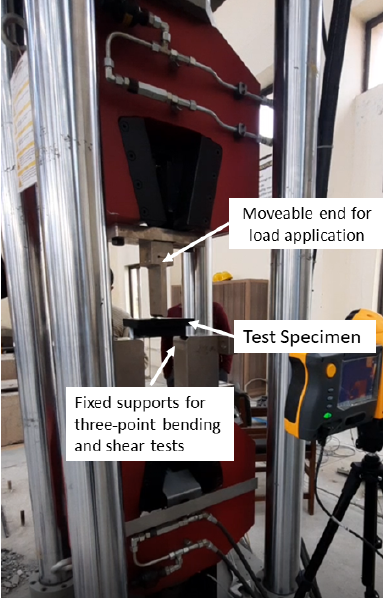
Figure 7. Three-point bending and shear test setup.